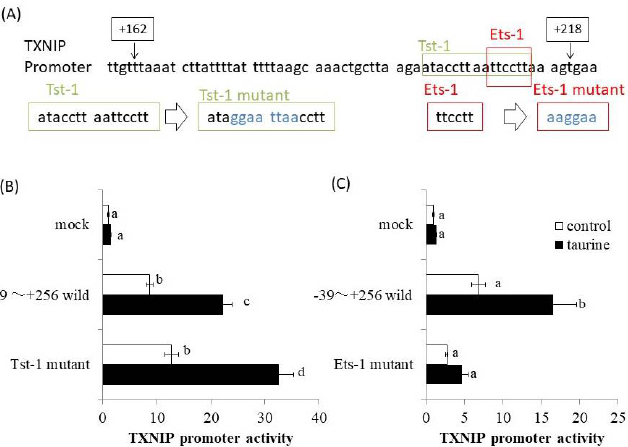
Figure 6. TXNIP promoter sequence (+162/+218) and the effect of taurine on TXNIP promoter activity by employing site-directed mutagenesis. ( A ) Human TXNIP promoter sequences between +162 and +218 are shown. The sequence of putative Tst-1 and Ets-1 response sequences and their mutants are shown, respectively. ( B , C ) Caco-2 cells were transfected with a reporter vector containing the partial promoter region of TXNIP ( − 39/+256; wild type, Tst-1 mutant, Ets-1 mutant) and then replaced with the medium containing 100 mM of taurine. After 24 h, the cells were subjected to the luciferase assay. Results are expressed as relative values with the control value of mock as 1. Each value is the mean ± S.E. ( n = 4) and the abcd values indicated by different characters are significantly different from each other and the abcd values indicated by the same characters are not significantly different (Tukey’s test; p <